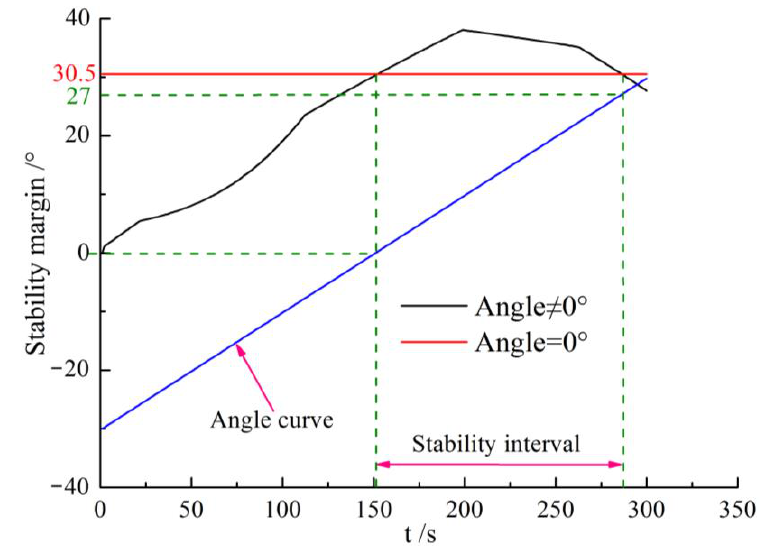
Figure 12. The stability margin curves.